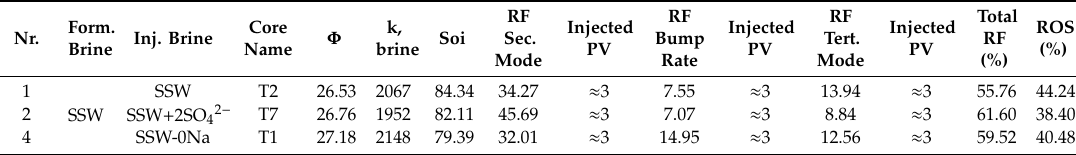
Table 5. Summary of selected core flooding results and comparison of obtained recoveries, data presented in